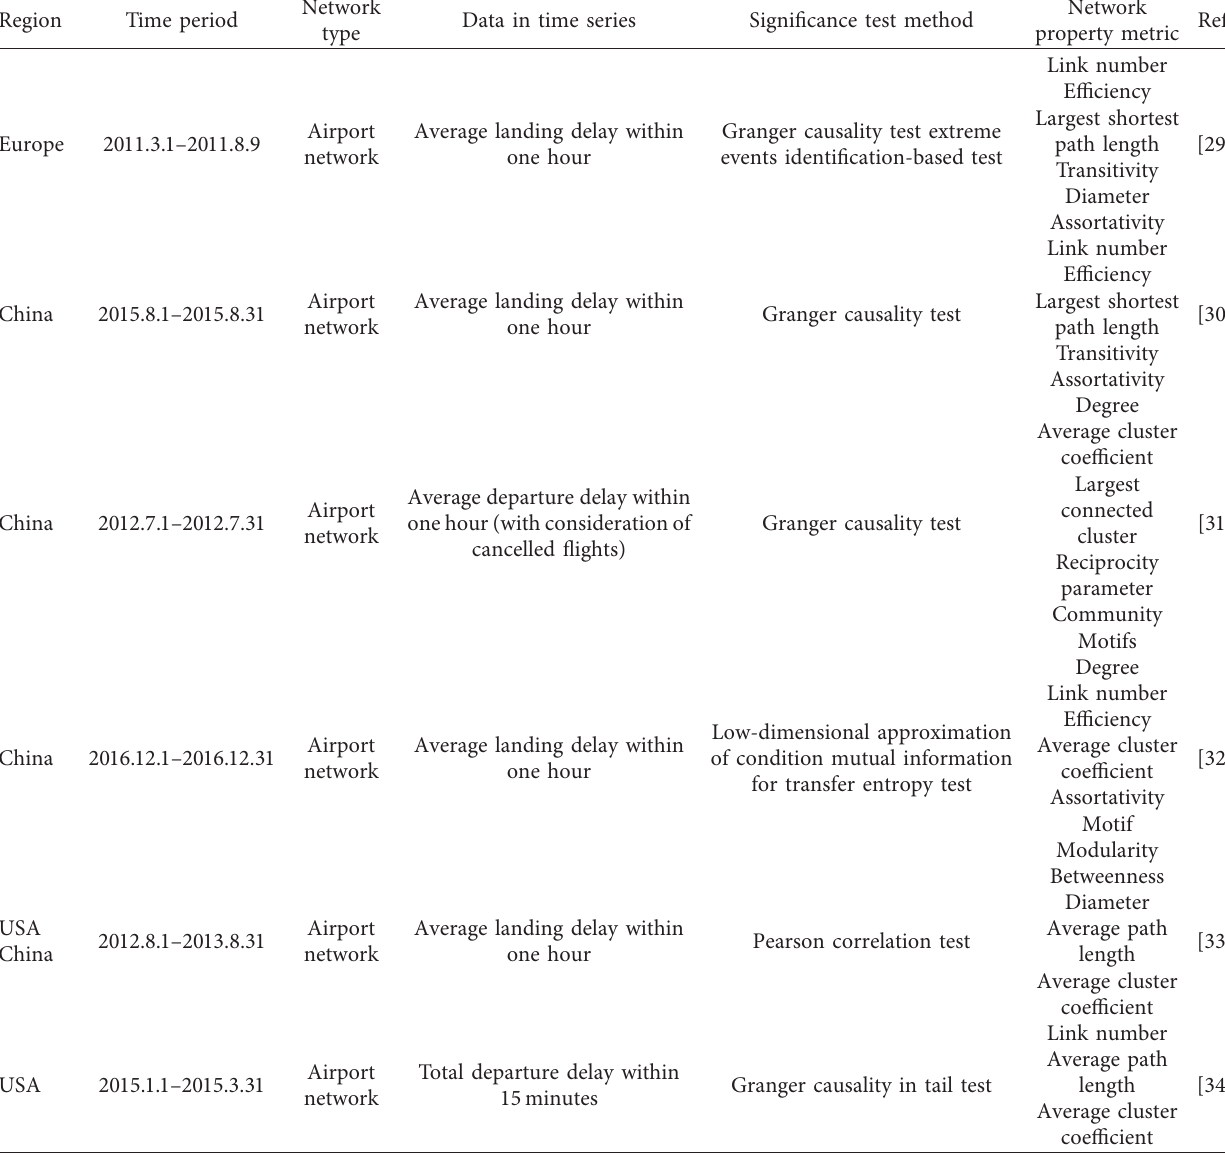
Table 6: Recent impact studies on flight delay